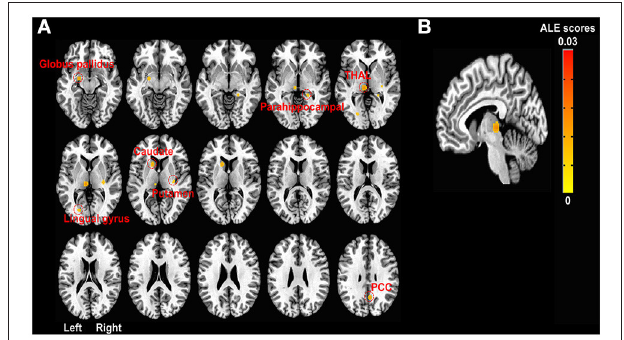
FIGURE 2 | ALE meta-analyses of fMRI studies in chronic pain patients during pain-related tasks. (A) Activation likelihood map showing seven deactivation clusters at uncorrected p < 0.001 and extent threshold k > 30. Deactivation clusters include the left thalamus ( − 6, 24, 0; 99 voxels), caudate ( − 14, − 14, 8; 55 voxels), globus pallidus ( − 20, 6, − 12; 51 voxels), lingual gyrus ( − 20, 76, 2; 31 voxels), and right parahippocampal gyrus (22, 38, − 4; 30 voxels), putamen (30, 22, 2; 36 voxels), and posterior cingulate gyrus (6, 58, 32; 52 voxels) after the chronic pain treatments compared to baseline (before the treatments) while patients with chronic pain were performing pain-related tasks (e.g., hand squeezing) or receiving painful stimulation. All clusters of activation (increased activation likelihood scores after pain treatments than before the treatments) at the uncorrected threshold were smaller than the minimum cluster size ( k > 30). (B) FWE rate corrected activation likelihood map showing the significant deactivation cluster in the left medial posterior thalamus ( − 6, 24, 0; 99 voxels) after the chronic pain treatments compared to the baseline (before the treatments) while chronic pain patients were performing pain-related tasks (e.g., hand squeezing) or receiving painful stimulation ( P < 0.05 at cluster-level and uncorrected P < 0.001 at voxel-level, k > 30). Seven out of ten leave-one-out sensitivity analyses also showed a significantly decreased likelihood of activation in the left thalamus (FWE corrected as above, cluster sizes range 99–100). No clusters of activation passed the multiple comparison correction threshold. ALE, activation likelihood estimation; FWE, Family-wise error; PCC, posterior cingulate cortex; THAL,